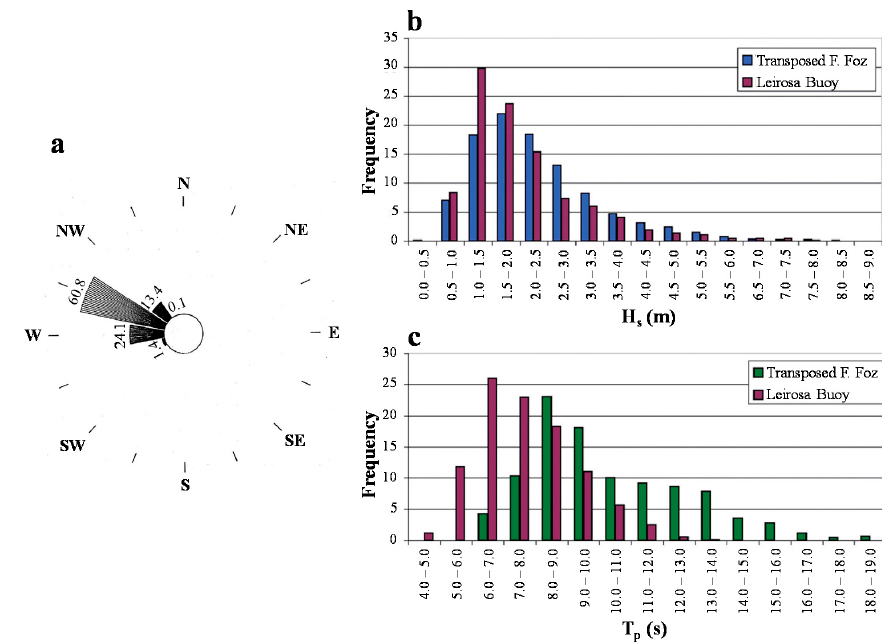
Figure 3. ( a ) Wave rose: wave direction relative frequency distribution (%) in Cabo Mondego, near Leirosa beach (adapted from [4]); and ( b , c ) frequency histogram for significant wave heights and peak periods, respectively, in Leirosa (red bar) (adapted from [1,2]).